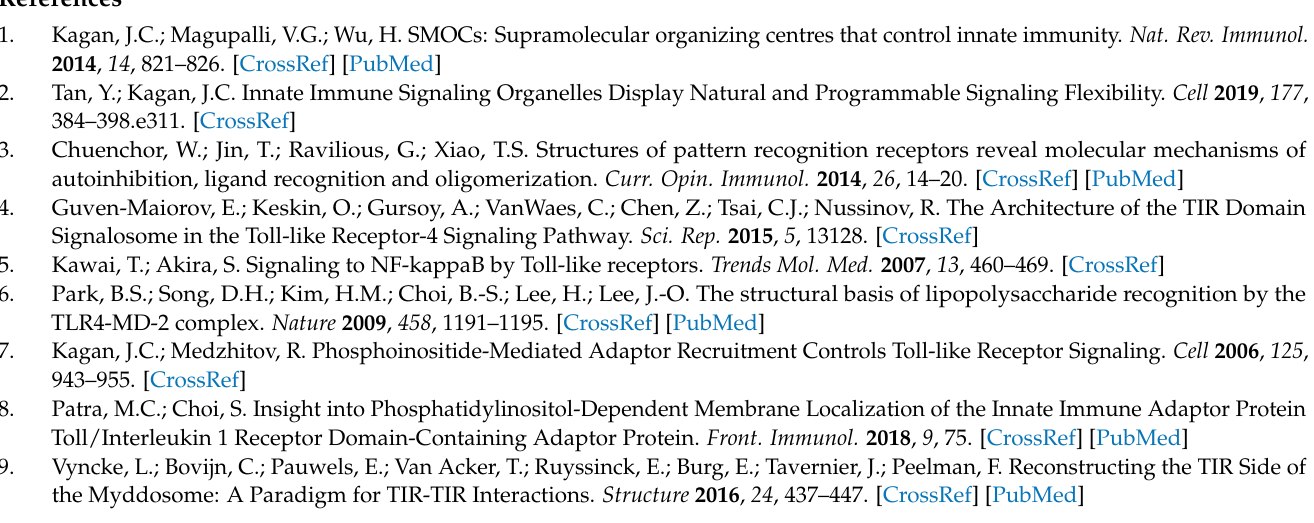
cells, Figure S2: Colocalization of human TIRAP with distinct membrane compartment markers, Figure S3: Expression of human TIR adaptor mutants in yeast is non-toxic, Figure S4: TRAM-mCherry filaments at the plasma membrane do not coincide with bud scars, Figure S5: Expression of human TLR4 C-terminal region (657-839), containing the TIR domain, is not toxic in yeast, Figure S6: Co- localization of TRIF-mCherry and EGFP-TRIF, Figure S7: Neither MyD88 nor TRIF co-localize with the Golgi marker P4C(SidC), Figure S8: mCherry-MyD88 colocalizes with Hsp-104-mNG labeled stress granules after heat shock at 42 ºC, Figure S9: TLR4(TIR)-induced TIRAP clusters recruit MyD88 in yeast, but TLR4(TIR)-induced TRAM clusters do not recruit TRIF, Table S1: S. cerevisiae strains used in this work, Table S2: Plasmids generated and used in this work, Table S3: Oligonucleotides used in this